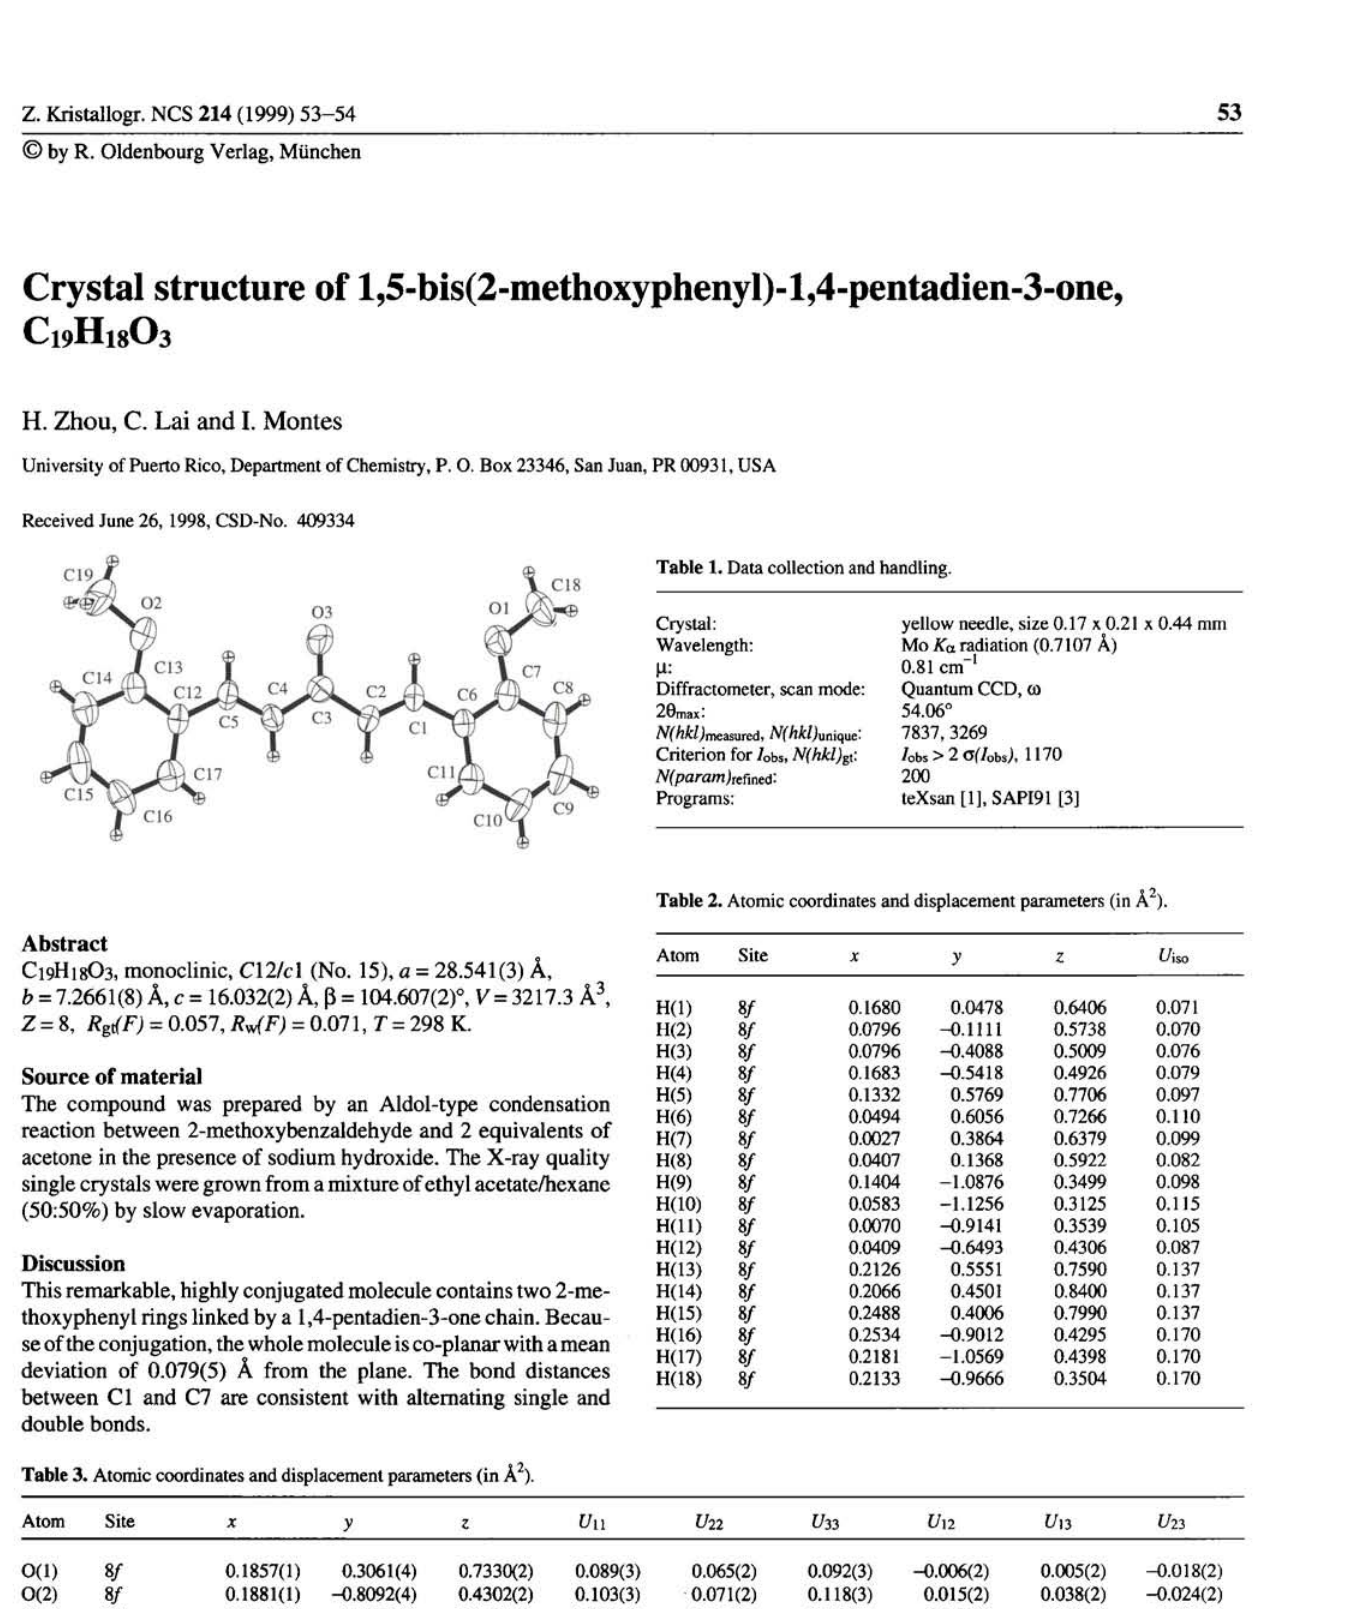
Table 3. Atomic coordinates and displacement parameters (in Â 2